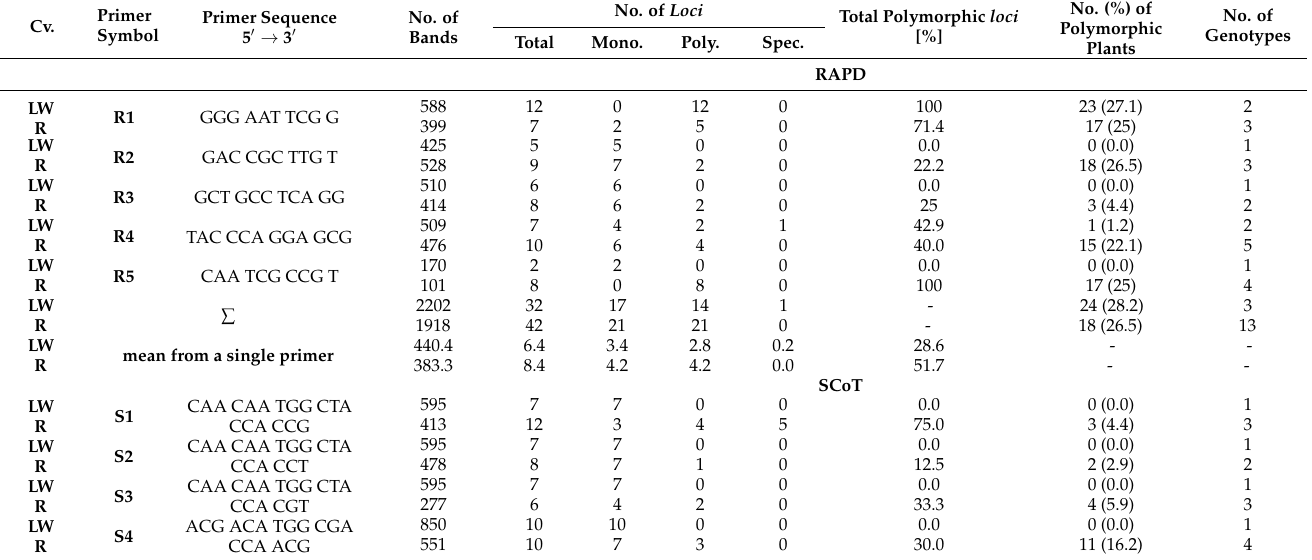
Table 4. Characteristics of molecular products obtained from Chrysanthemum × grandiflorum ‘Lilac Wonder’ (LW) and ‘Richmond’ (R) analyzed with randomly amplified polymorphic DNA (RAPD) and start codon targeted polymorphism (SCoT)